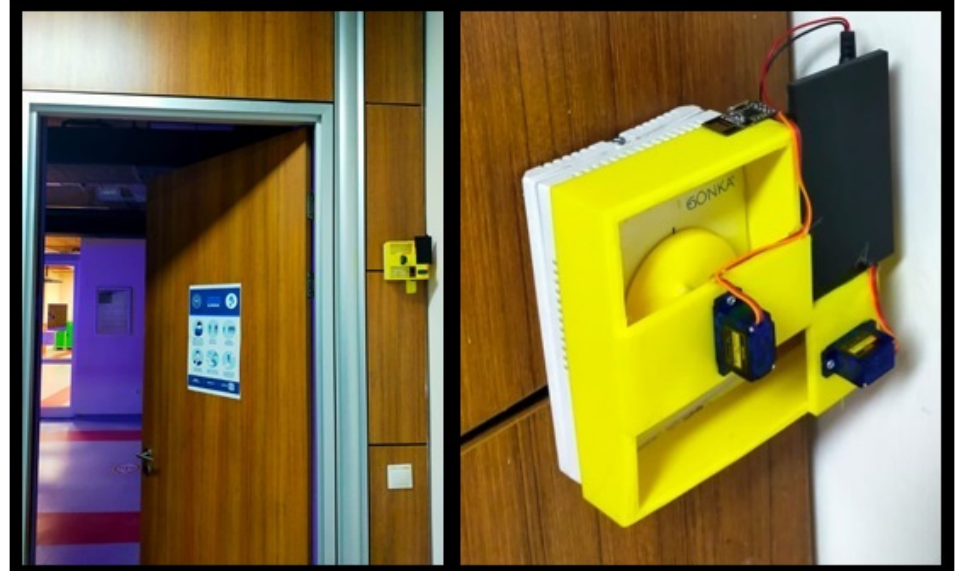
Figure 10. Dynamic air conditioning control system .